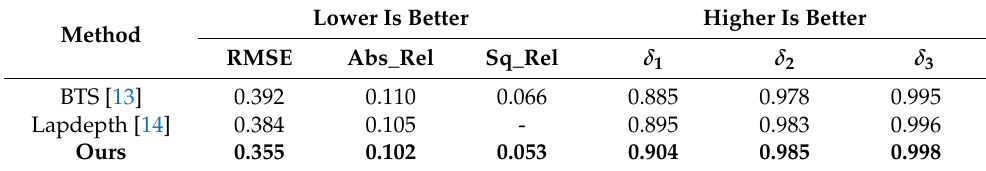
Table 2. Performance comparison using NYU Depth V2 dataset with BTS and Lapdepth.